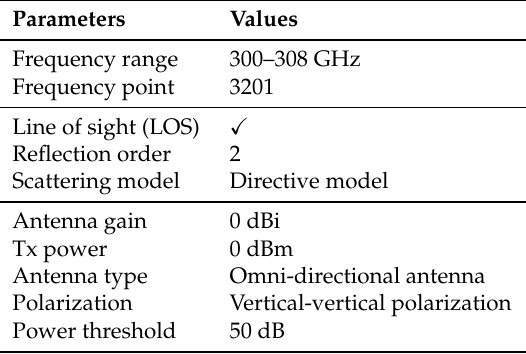
Table 2. Simulation configuration.